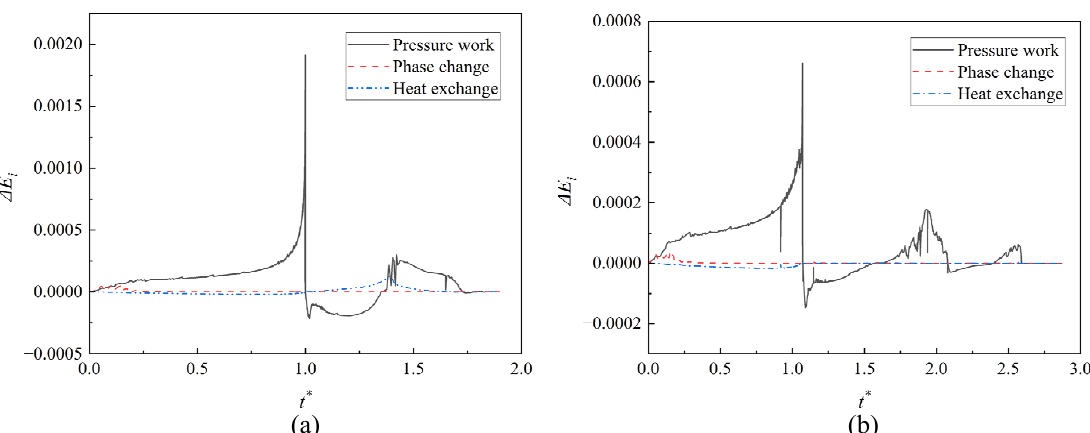
Figure 12. Temporal evolution of the internal bubble energy. ( a ) Bubble collapse in the far-field region; ( b ) bubble collapse near the wall.